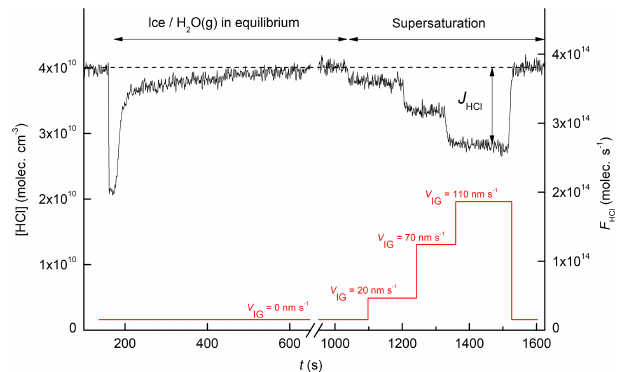
Figure 2. The black line represents the time series of the HCl con- centration (left y axis) or flux (right y axis) during an experiment at 213K. Prior to t = 1040s, the ice was in equilibrium with the gas phase H 2 O concentration. After t = 1040s, the ice was supersatu- rated with respect to the gas phase, and the red line indicates the ice growth velocity, V IG (based on the H 2 O signal at m/z 20), during the